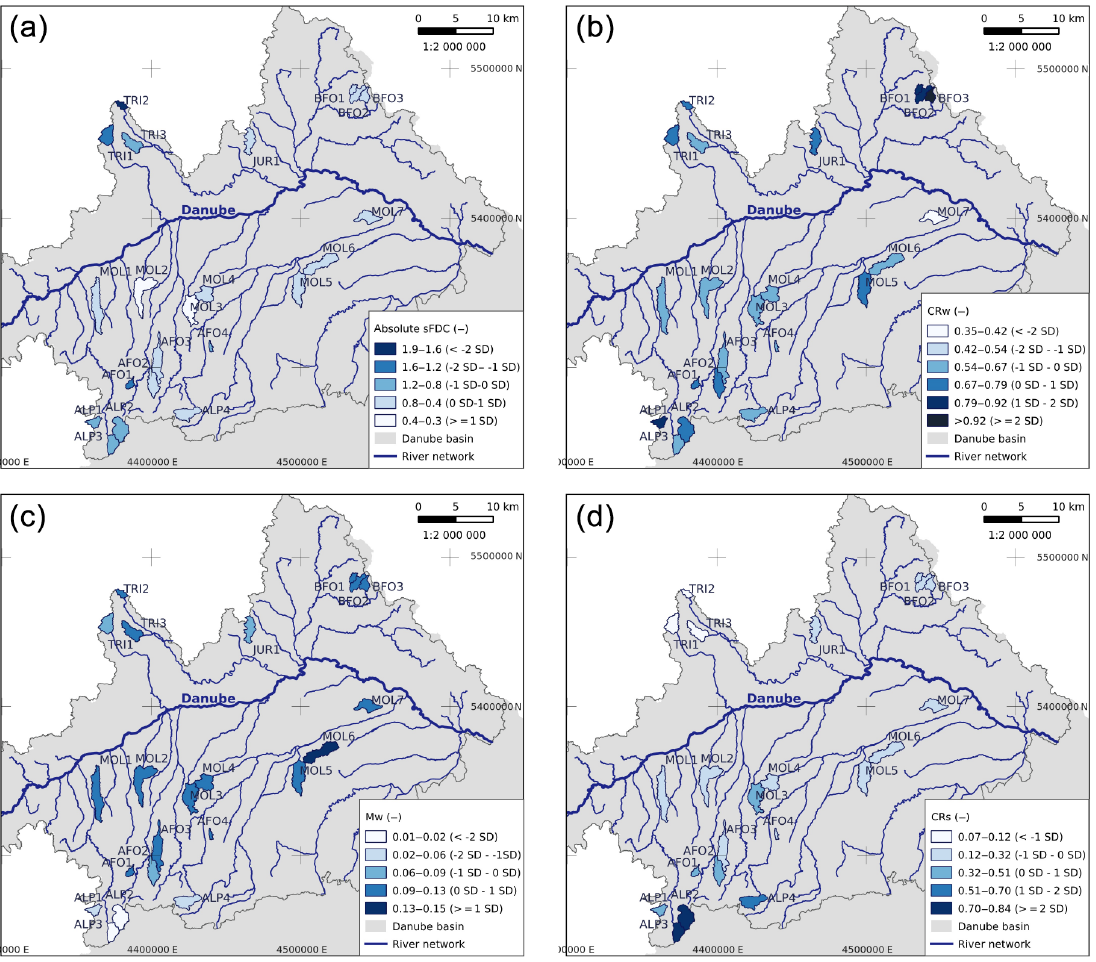
Figure 7. The panels show maps of (a) absolute values of the slope of the flow duration curves (sFDC) (–), (b) winter runoff coefficients (CR W ) (–) obtained from the type I dDMC, (c) the winter rate of how fast dimensionless relative release grows with the potential renewal rate of the soil stock (m W ), and (d) summer runoff coefficients (CR S ) (–). The applied colour code is derived from the standard deviation of each data